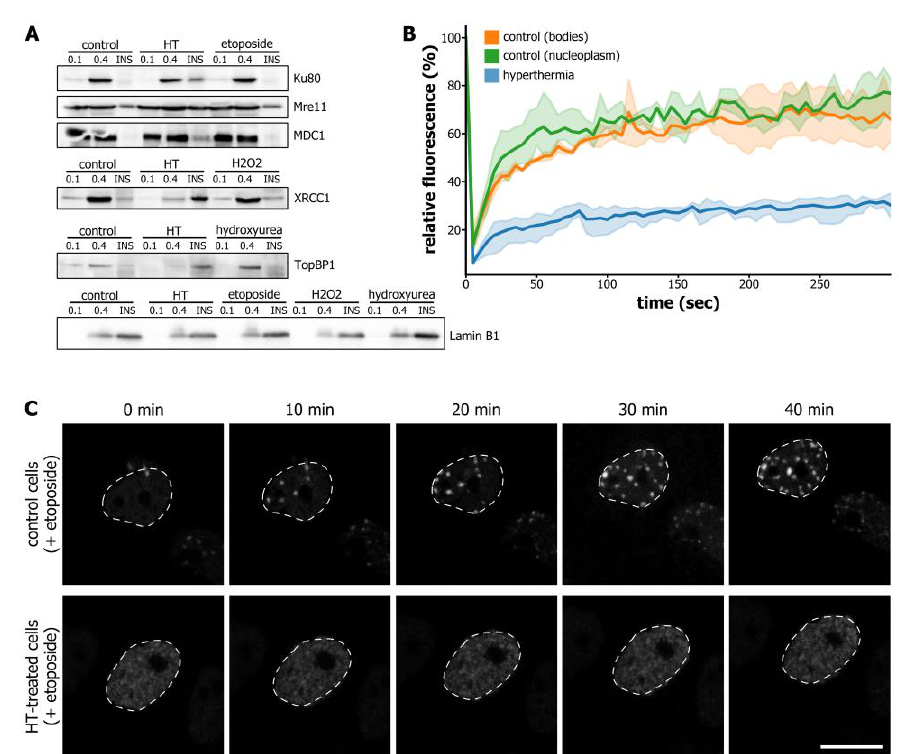
Figure 2. Hyperthermia-induced c -trapping can be a mechanism of DNA repair deficiency. ( A ) Western blot analysis of Ku80, Mre11, MDC1, XRCC1, and TopBP1 in di ff erent chromatin fractions (see Figure 1A) prepared from control HeLa cells and HeLa cells treated either with hyperthermia (45 ◦ C, 30 min) or specific DNA damage-inducing drug (etoposide, 20 µ g / mL, 60 min; hydrogen peroxide (H 2 O 2 ), 200 µ M, 60 min; hydroxyurea, 10 mM, 60 min). Lamin B1 is used as a loading control. ( B ) Kinetics of 53BP1-GFP studied by fluorescence recovery after photobleaching (FRAP) in control HeLa cells and HeLa cells exposed to hyperthermia (45 ◦ C, 30 min). In control cells, the kinetics of 53BP1-GFP was analyzed both in 53BP1 nuclear bodies and in the nucleoplasm. The shaded parts of the lines represent s.d., n = 9. ( C ) Transiently transfected with 53BP1-GFP HeLa cells were mock-treated or treated with hyperthermia (45 ◦ C, 30 min) and then incubated with DNA double-strand break (DSB)-inducing drug etoposide (20 µ g / mL, 60 min). Time-lapse imaging of 53BP1-GFP was performed. A representative image is shown. Scale bar: 10 µ